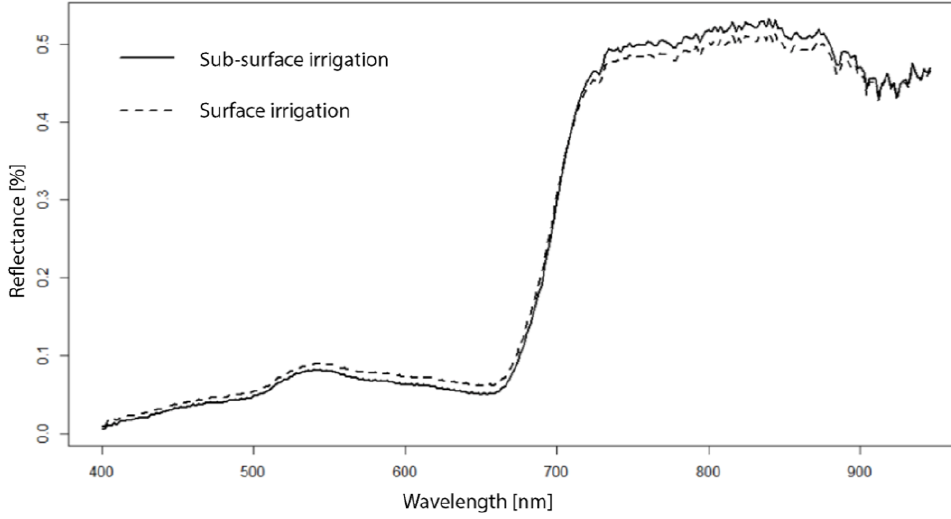
Figure 4. Average raw spectra reflectance curves of olive canopies irrigated with SDI or DI.